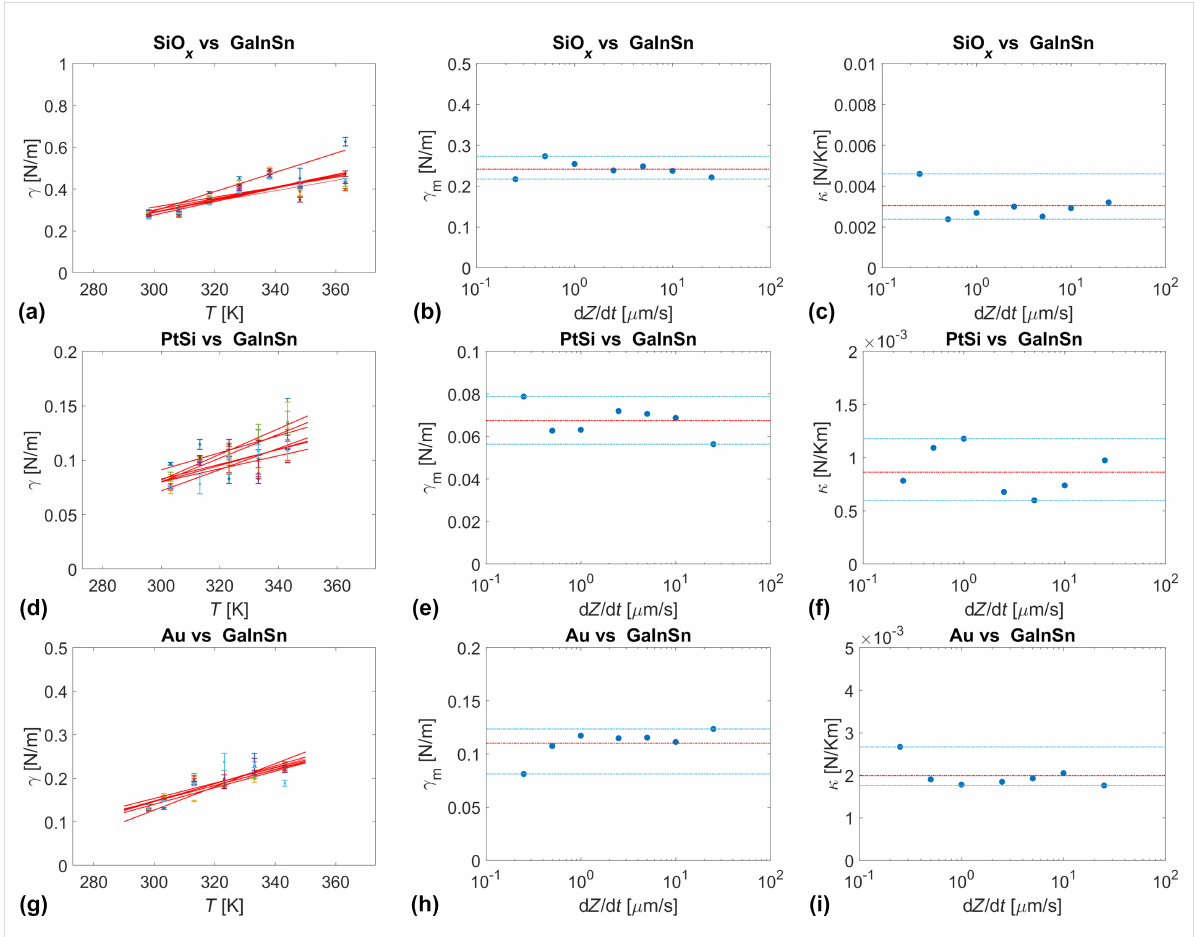
Figure 5: (a, d, g) Interfacial energy γ as a function of the temperature determined with d Z /d t = 0.25–25 mm/s; (b, e, h) interfacial energy at the melting point γ m as a function of d Z /d t (the mean value of γ m is indicated as a red dashed line and the range of values is indicated by two blue dashed lines); (c, f, i) temperature sensitivity κ of the interfacial energy as a function of d Z /d t (the mean value of κ is indicated as a red dashed line and the range of values is indicated by two blue dashed lines).